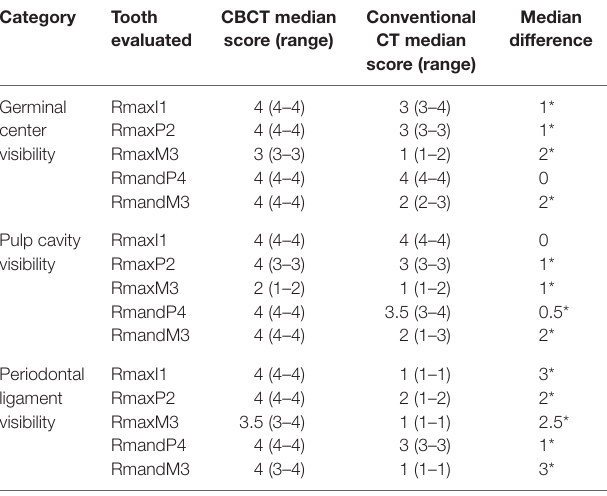
TaBle 3 | Median score, range, and median difference of cBcT and conventional cT transverse, sagittal, dorsal, and custom MPr images for the germinal center, pulp cavity, and periodontal ligament